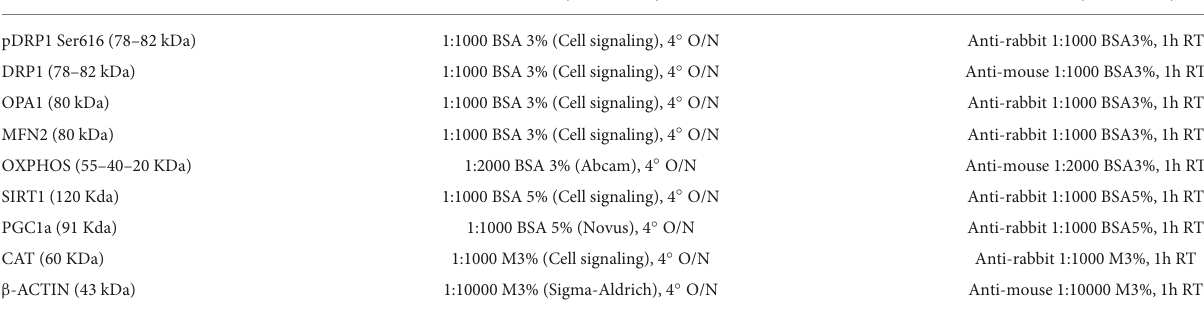
TABLE 1 Antibodies conditions used in the western